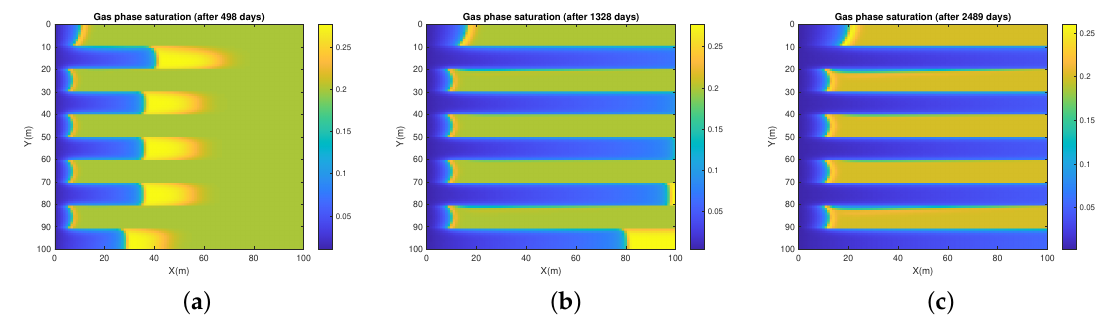
Figure 9. Gas saturation at different time for Example 2: ( a ) Gas saturation (after 498 days). ( b ) Gas saturation (after 1328 days). ( c ) Gas saturation (after 2489 days).